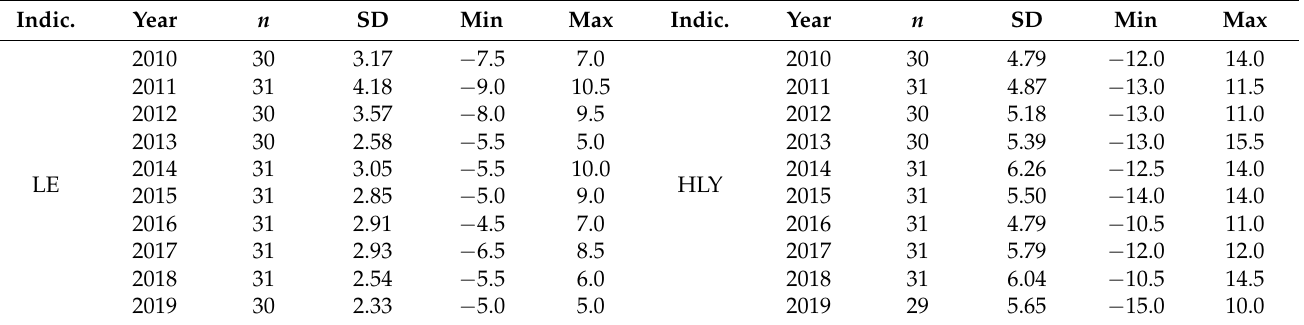
Table 3. Descriptive statistics for rank differences between the older population and the total population